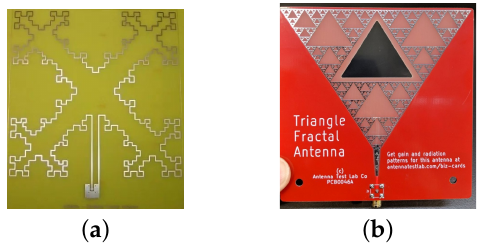
Figure 24. Some commercial antennas used in mobile phones and other applications, ( a ) Microstrip patch antenna, ( b ) Sierpinski triangle